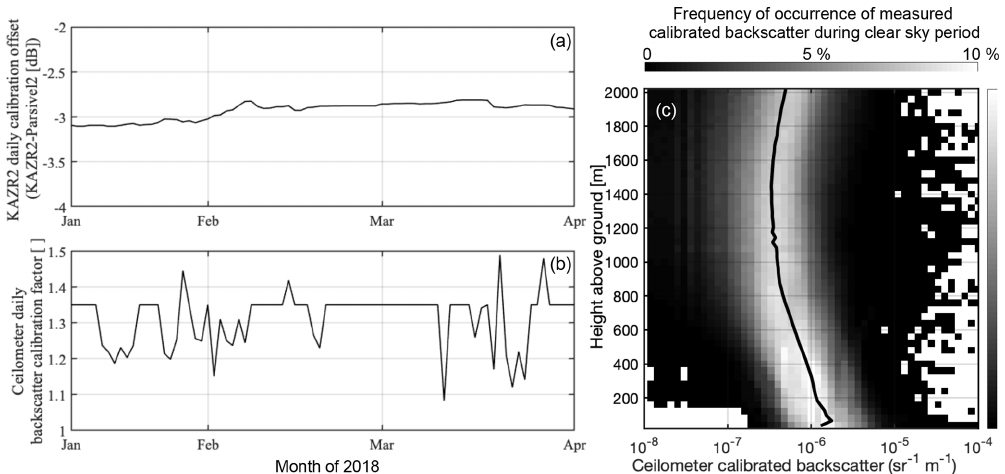
Figure 2. (a) Ka-band zenith radar (KAZR2) calibration offset to be removed from the KAZR2 radar reflectivity in order to match Parsivel disdrometer radar reflectivity estimates. (b) Ceilometer lidar calibration factor to be multiplied to observed backscatter to match theoretical liquid cloud lidar ratios. (c) Frequency of occurrence of observed backscatter during clear sky conditions, solid black line is interpreted as the mean aerosol backscatter signal, observations smaller than this threshold at each height are eliminated from the drizzle analysis.